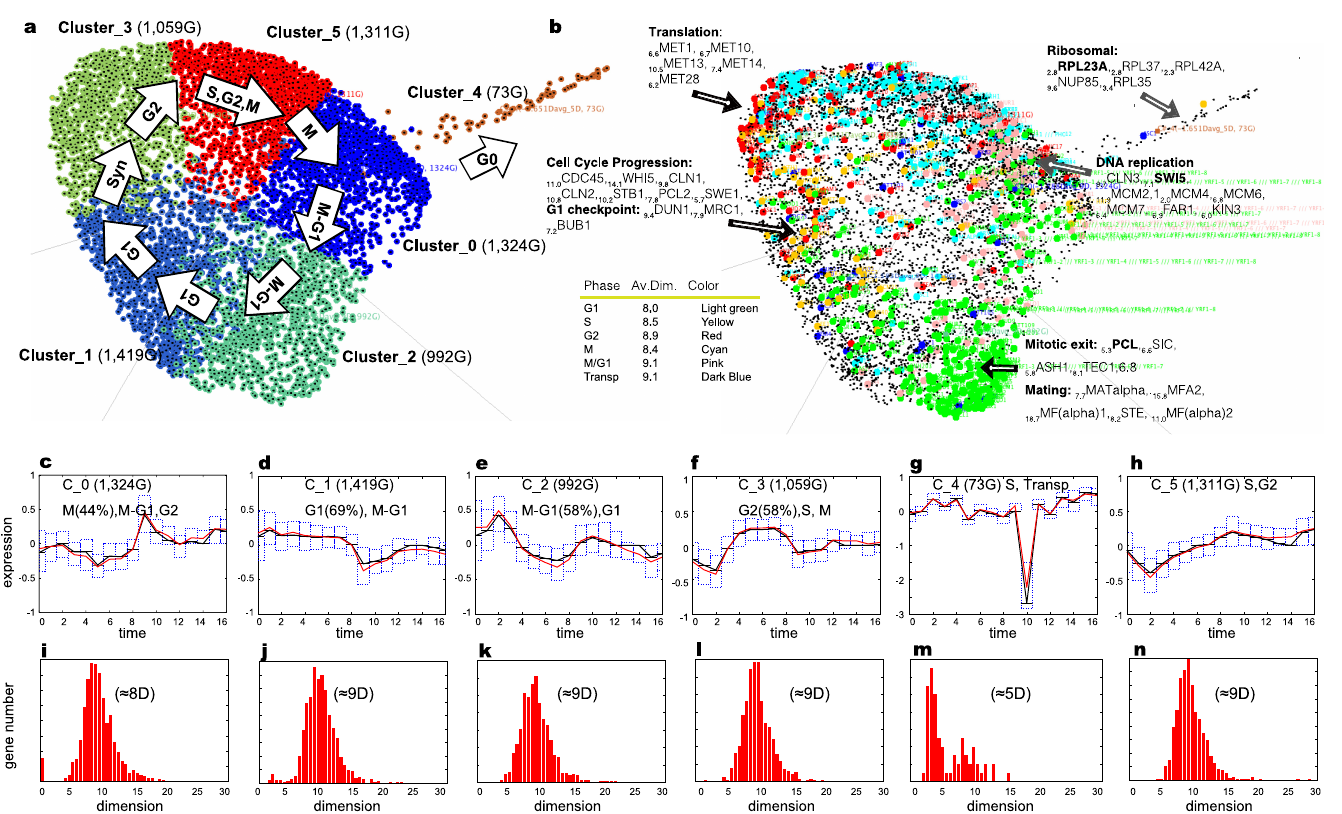
Fig 3. Clusters for the Yeast Metabolic Cycle (YMC) dataset (9,334G, 36 time points, 300 minutes): (a) Metabolic clusters aligned with the cell cycle. (b) YMC sentinel genes with average local dimension for each YMC phase in the table near the manifold. (c) YCC sentinels depicted by colored balls with a mean dimension for each YCC phase in the table near the manifold. Top Barycentre genes at a high local dimension are shown with respective dimensions in brackets and are pointed to with lines. (d)–(g) Cluster expression profiles, with candlesticks (solid red: average values; solid black: median values). Boxes indicate the Q25, Q50 (black), and Q75 quantiles. The x-axis shows time point tags, and Y-axis shows gene expression. (h)–(k) Dimension histograms of local dimensions (X-axes) and the number of genes (Y- axes) for respective clusters in (d)–(g). Local dimension scale of X-axes in (d)–(g) fits the scale of ambient space (X-axes) in (h)–(k).